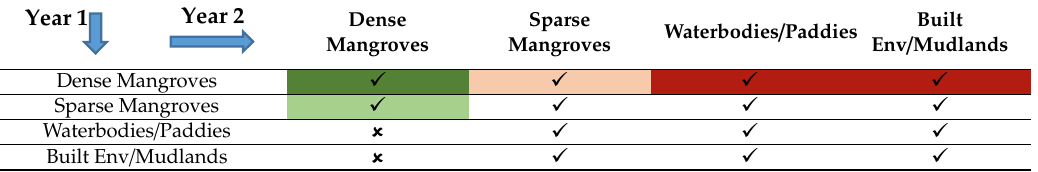
Table 2. Scheme of logical inter-annual land use changes. Color scheme indicates a classification of mangrove forest land use change trends. The color scheme also applies multi-annually.